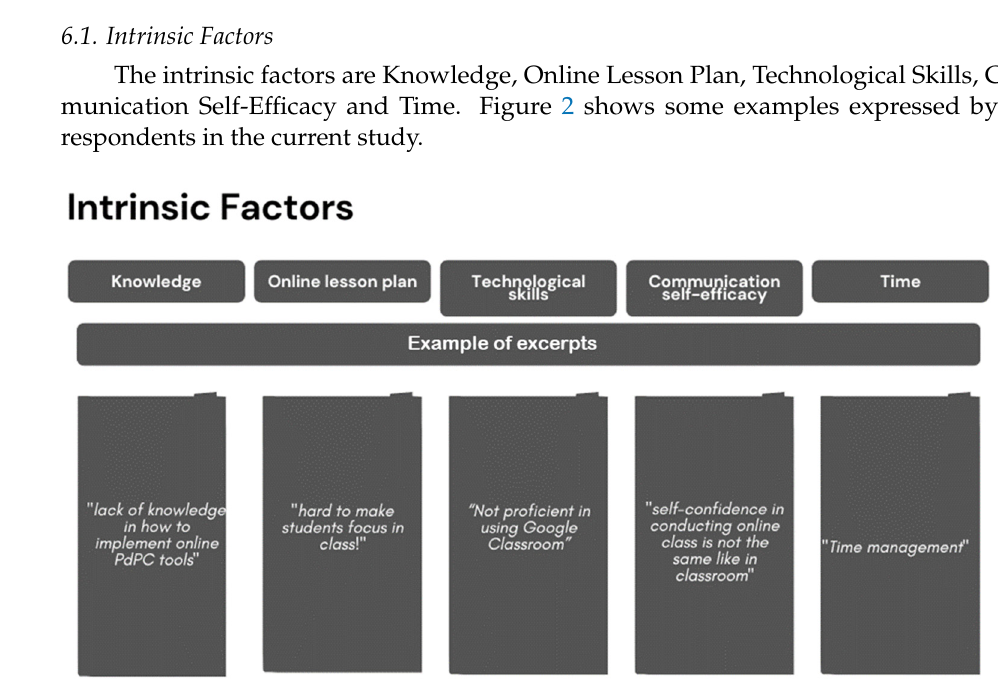
Figure 2. Intrinsic Factor .